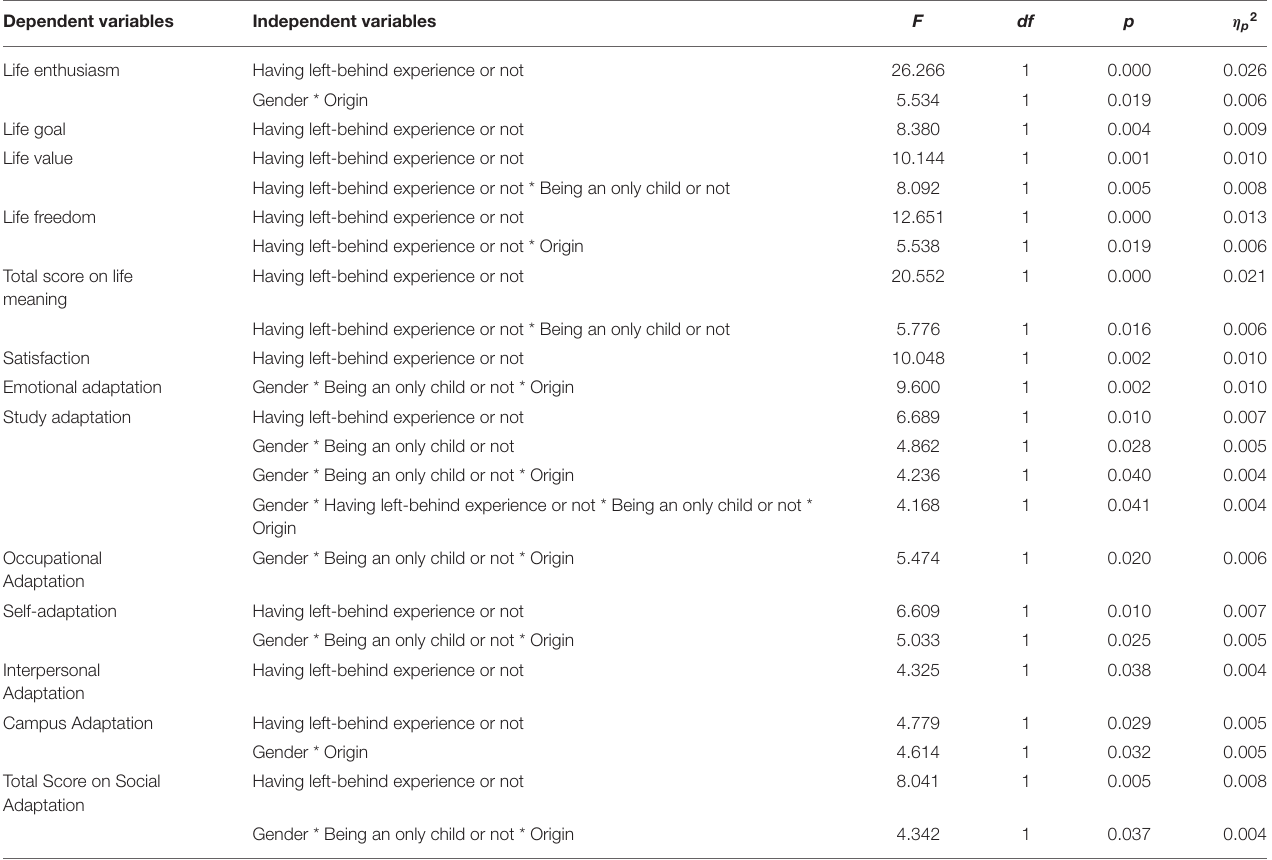
TABLE 3 | Multi-factor ANOVA of MLS and SAS scores ( n =